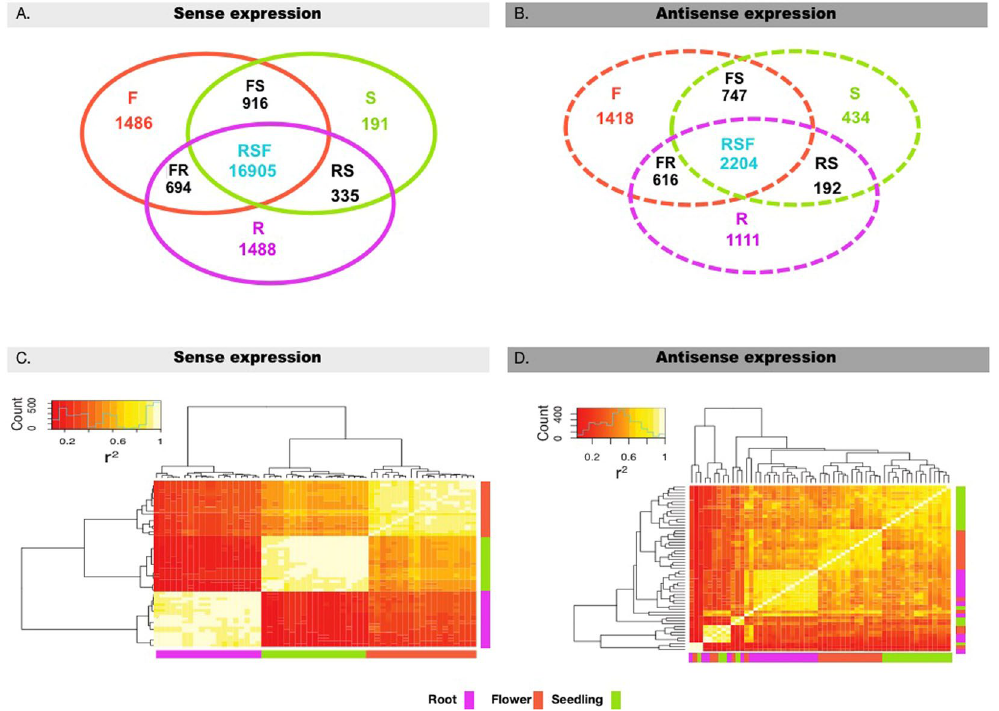
Figure 1. Gene expression in root, flower and seedling across 19 A. thaliana accessions. ( A ) Venn diagram of the counts of genes with sense expression in root, flower and seedling across 19 accessions. ( B ) Venn diagram of the counts of genes with antisense expression in root, flower and seedling across 19 accessions. ( C ) Heatmap of sense expression in three organs across 19 accessions. ( D ) Heatmap of antisense expression in three organs across 19 accessions. F: Flower-specific expressed genes; S: Seedling-specific expressed genes; R: Root-specific expressed genes; FS: genes with expression shared by Flower and Seedling only; FR: genes with expression shared by Flower and Root only; RS: genes with expression shared by Root and Seedling only; RSF: genes with expression shared by Root, Seedling and